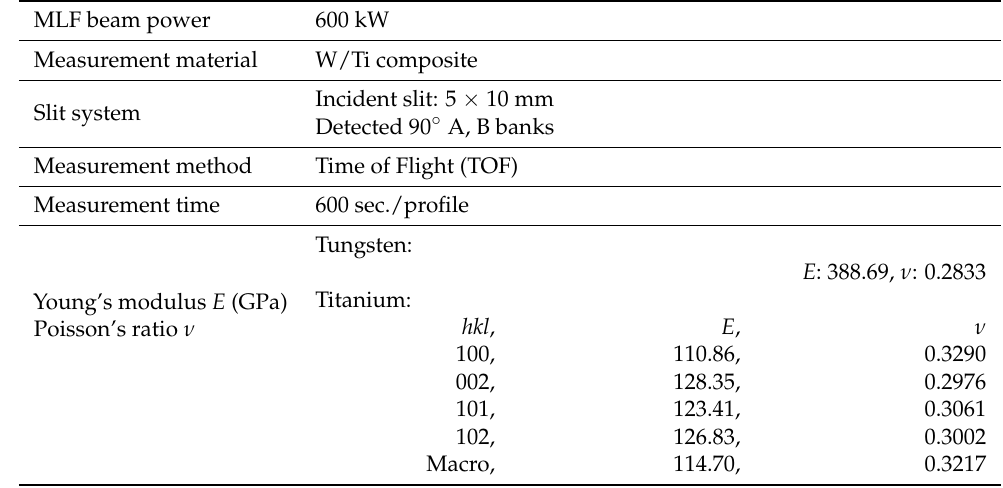
Table 2. Conditions of neutron stress measurement by